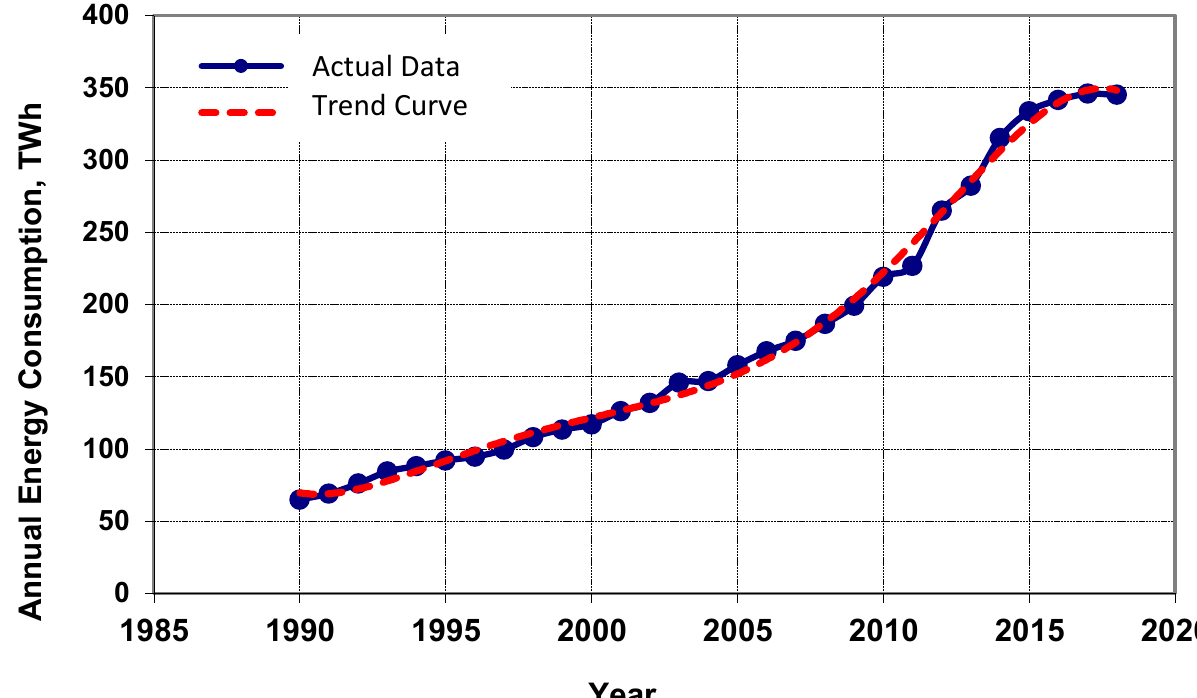
Figure 3. The annual increase in domestic energy use in Saudi Arabia [3,5].